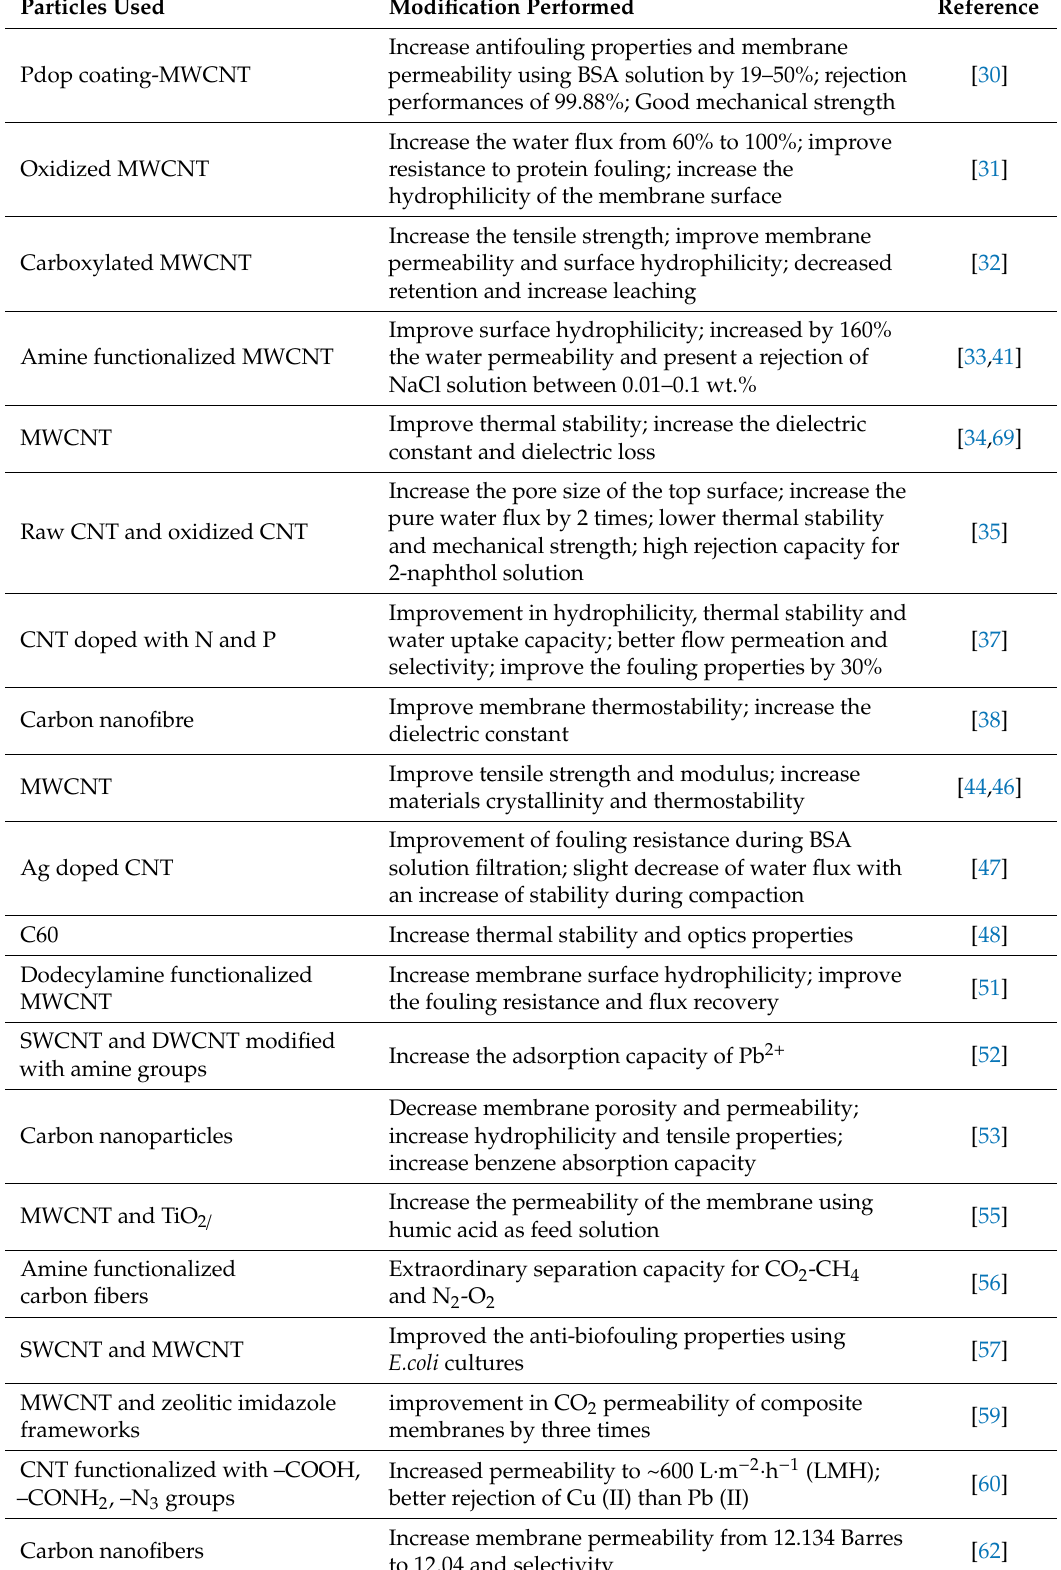
Table 1. Summarized applications for presented